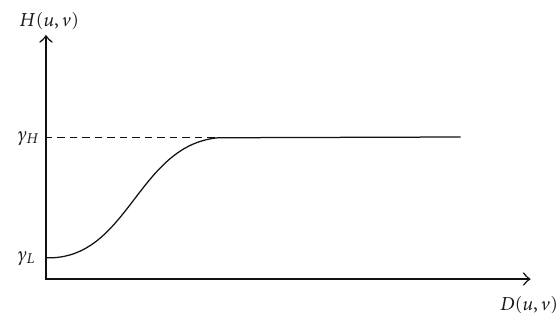
Figure 7: Cross-section of homomorphic filter